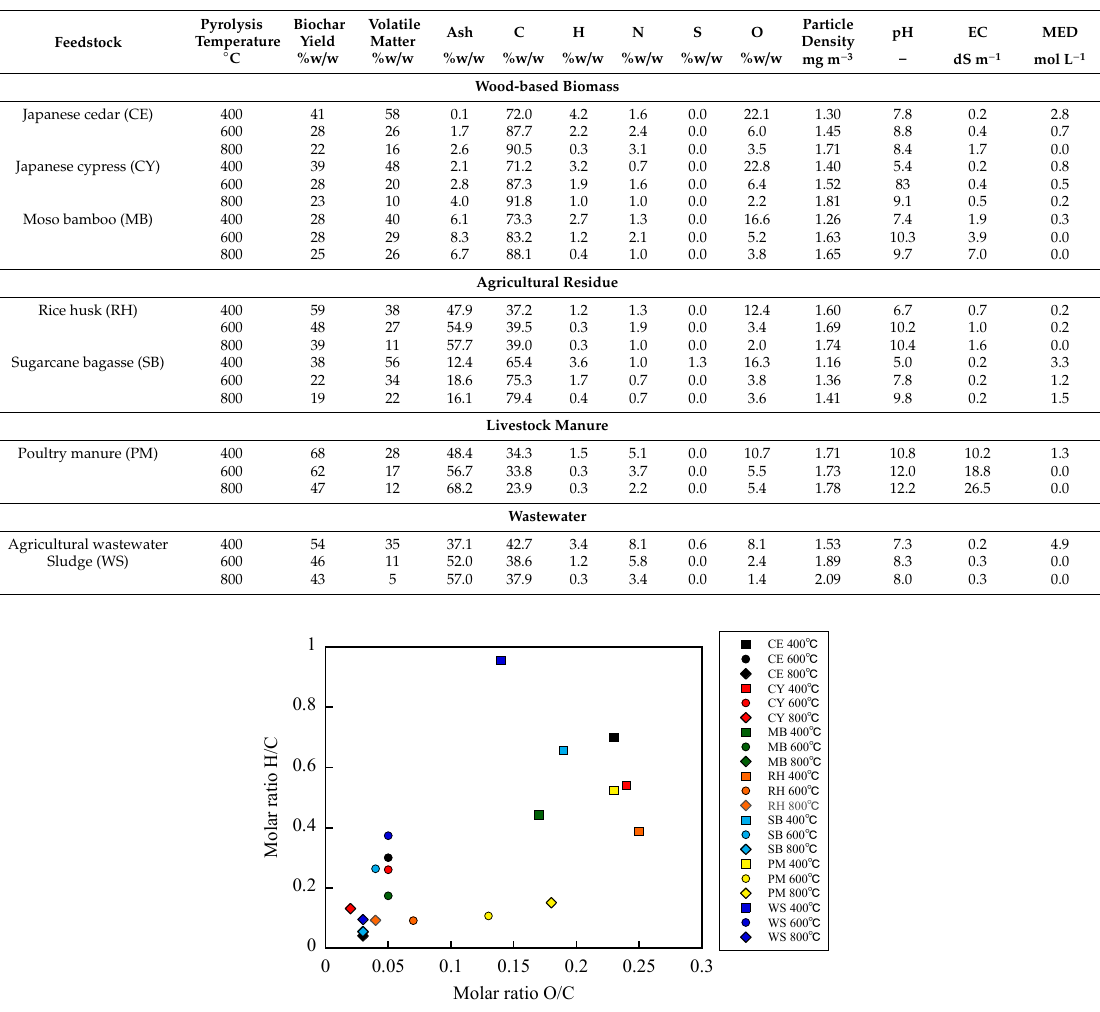
Table 1. Physicochemical properties of biochar samples.